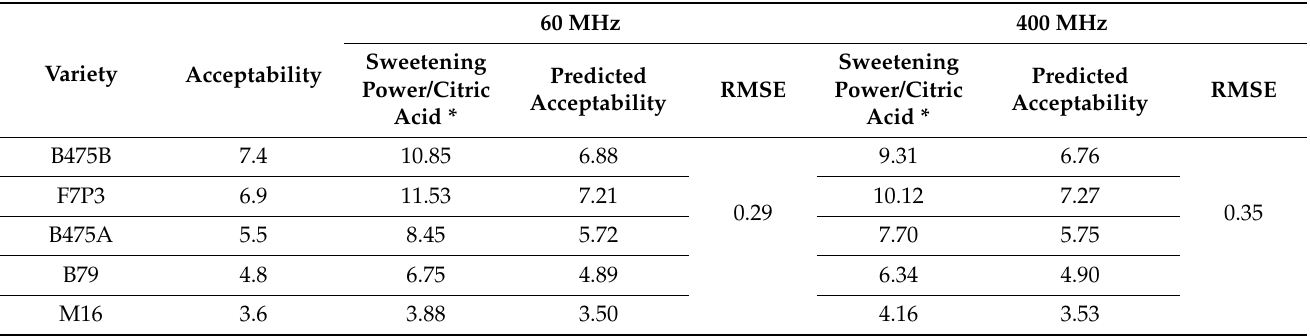
Table 1. Results of the sensory evaluation (acceptability), sweetening power/citric acid ratio, predicted acceptability using the model and RMSE of the prediction of each model (60 and 400 MHz